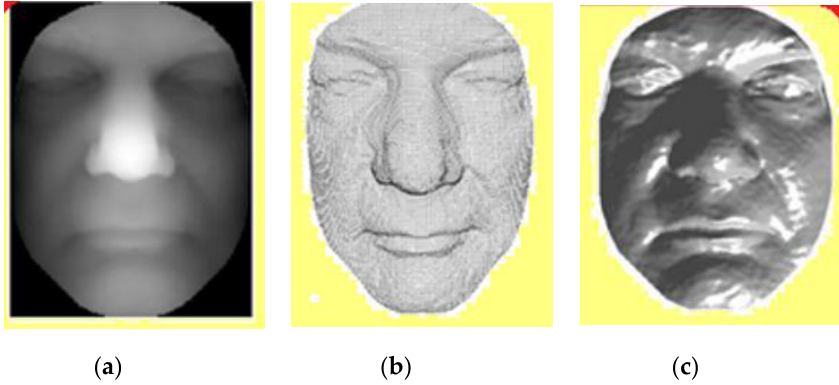
Figure 28. Three widely used 3D scanners. ( a ) . Example of a 3D facial image acquired with a triangulation-based device, known as depth image, ( b ) . example of a 3D facial image acquired with a structured light-based device, known as point cloud, ( c ) . example of a 3D facial image acquired with passive acquisition device, known as mesh.